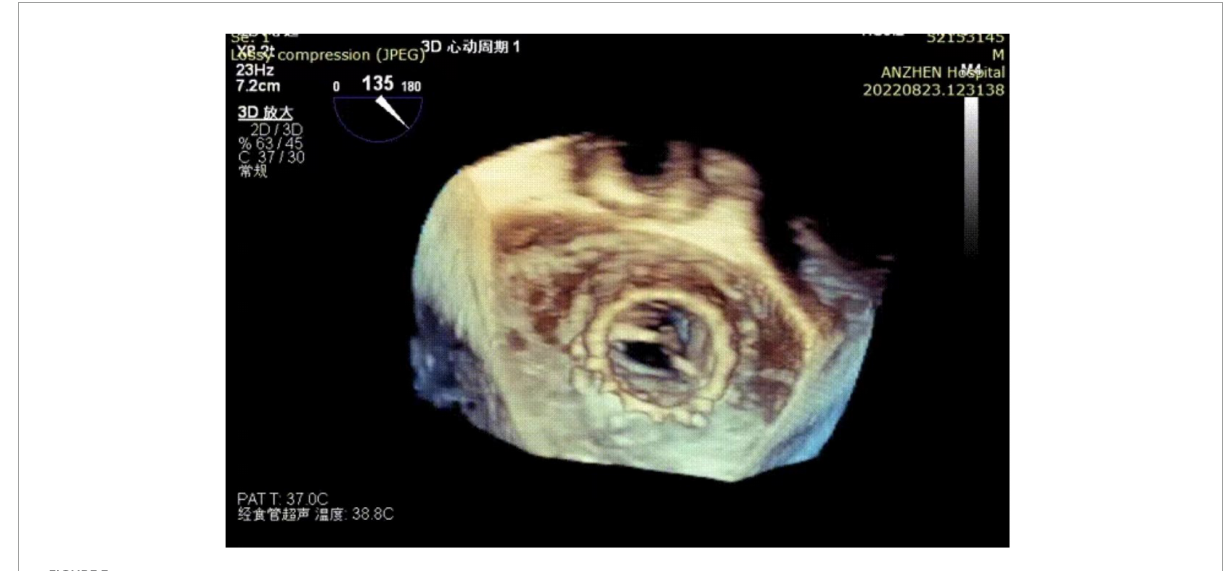
FIGURE3 Three-dimensional transesophageal echocardiography reconstruction showing the mitral transcatheter heart